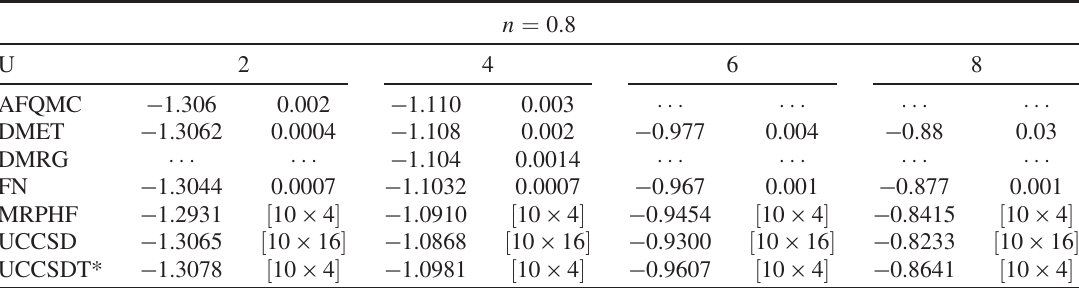
TABLE IV. Zero-temperature energy and uncertainty for n ¼ 0 . 8 , T ¼ 0 , for a range of interaction strengths U , obtained from AFQMC (constrained path), DMET, DMRG, FN, MRPHF, and UCCSD. Where extrapolations to the TL are not available, finite-size geometries are listed in lieu of uncertainties.